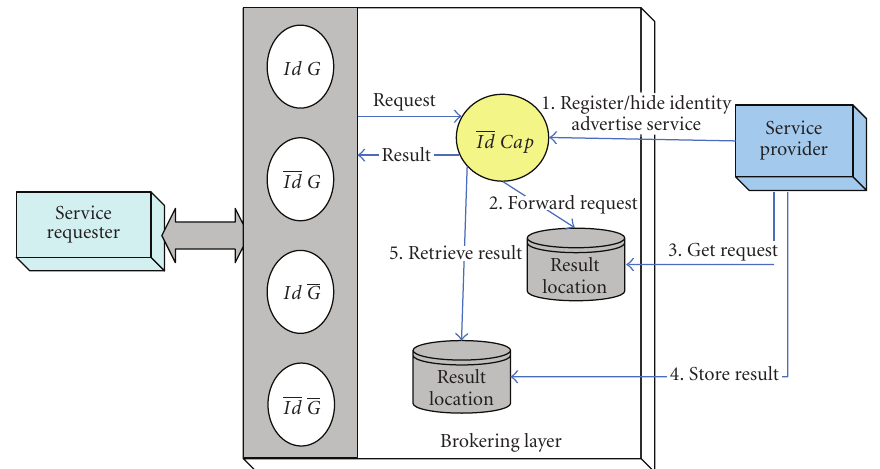
Figure 7: Interaction pattern for providers hiding identity.